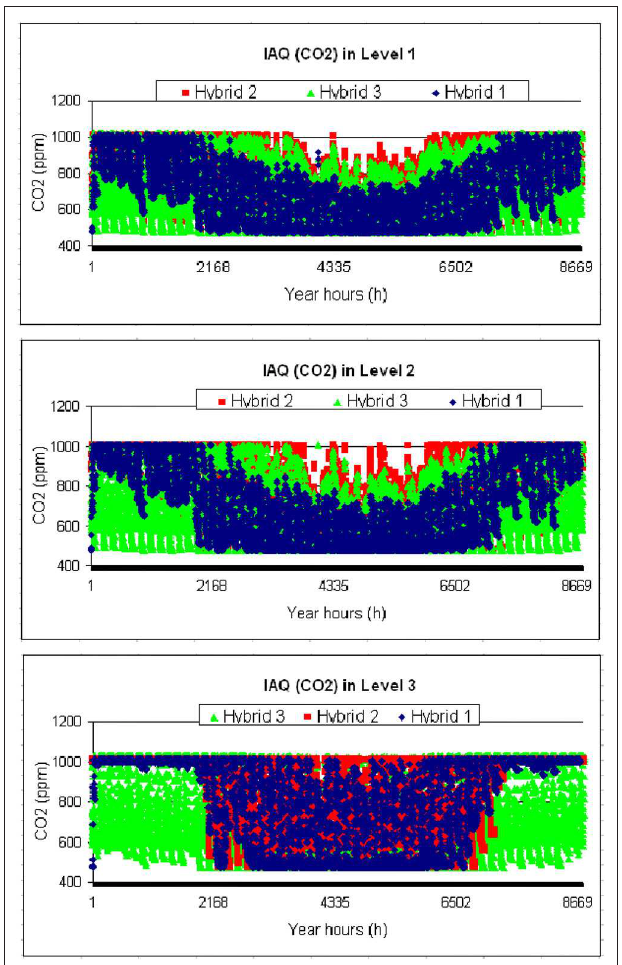
FIGURE 10 | CO 2 as a measure for the indoor air quality in the building levels for the proposed hybrid ventilation strategies.